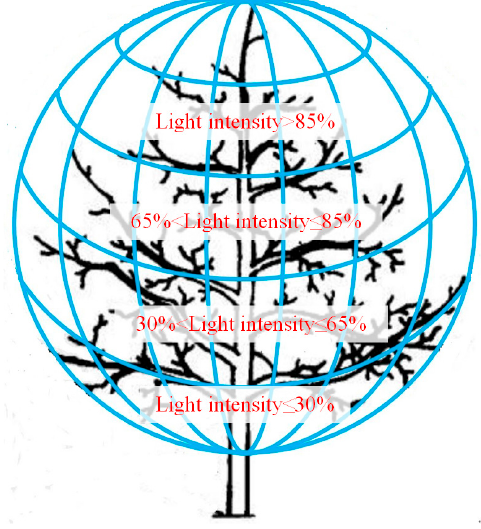
Figure 2. RLI in an ideal free spindle-shaped apple tree.